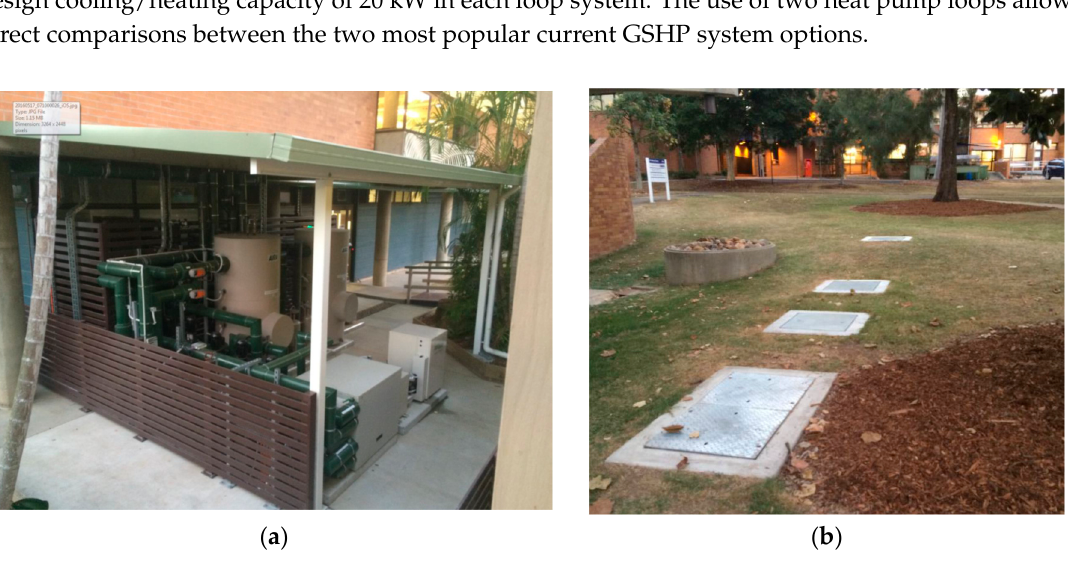
Figure 1. ( a ) The main ground components of the ground source heat pump (GSHP) system; and ( b ) the three monitoring wells in direct expansion (DX) loop.